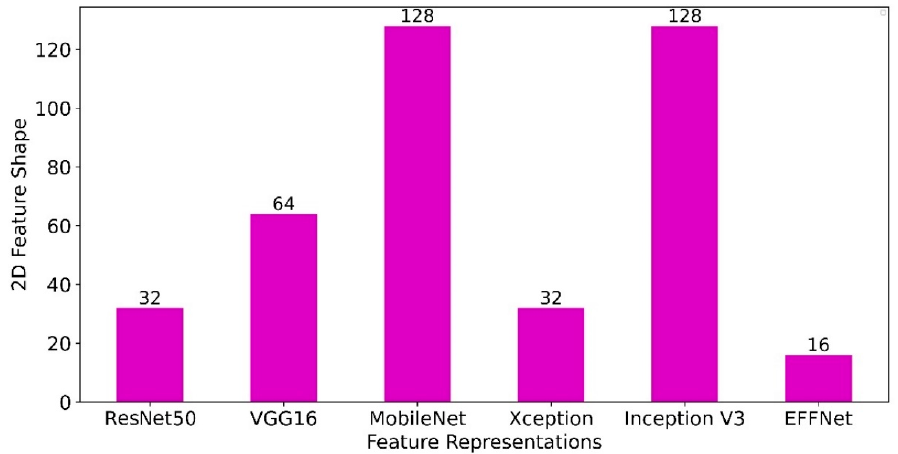
Figure 8. The shape of the feature representation’s features (Conv2D).